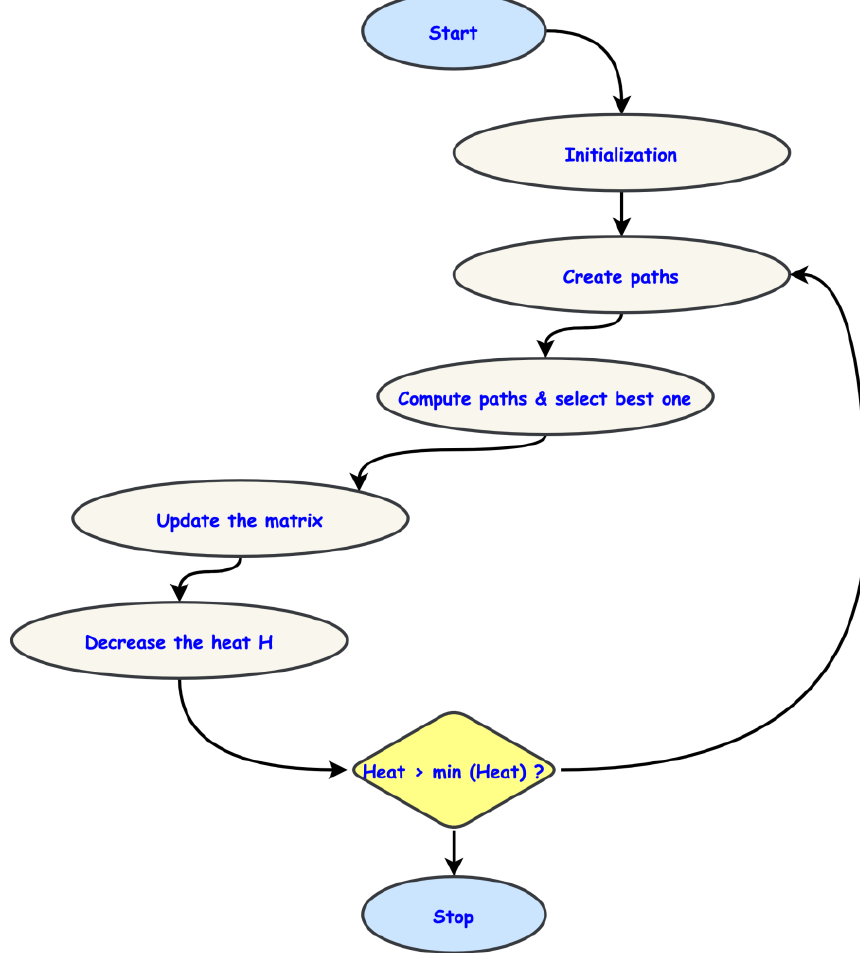
Figure 3. Workflow of the optimization algorithm. Algorithm 1: The optimization algorithm for finding the best route